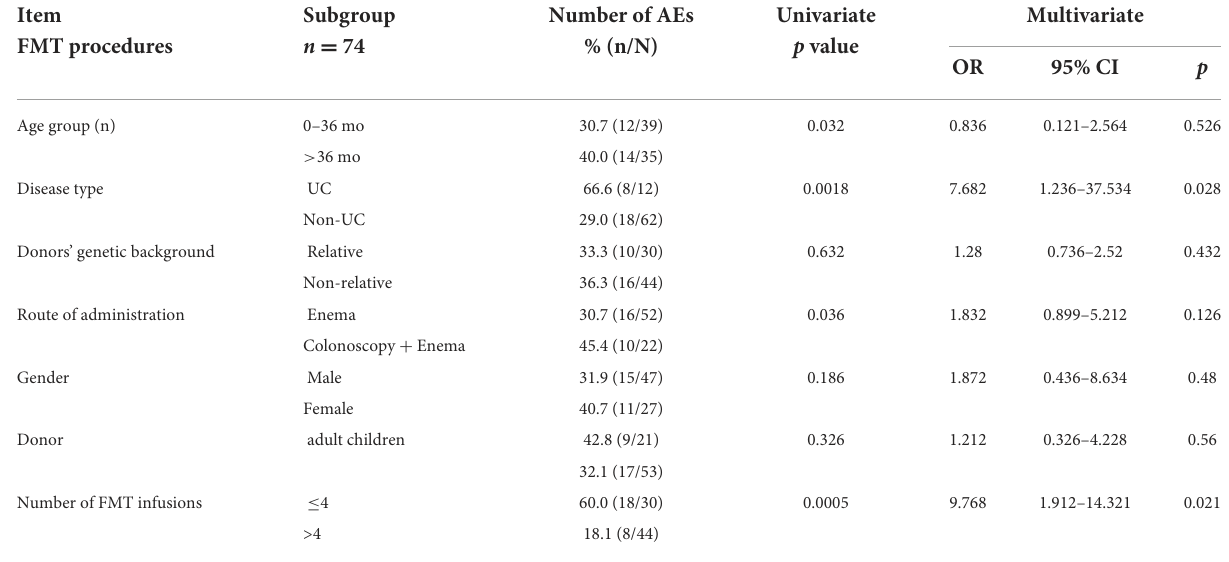
TABLE 3 Potential factors influencing FMT-related AEs